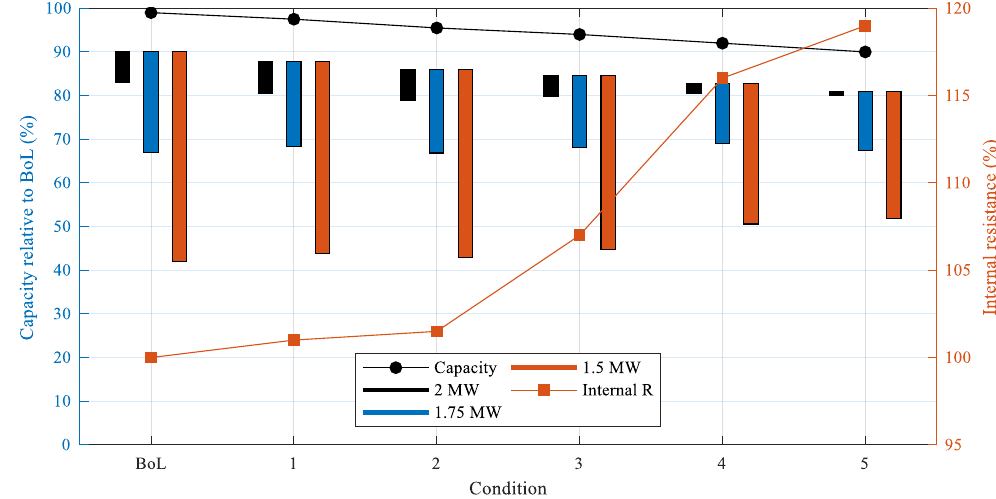
Figure 11. Battery system operating envelope with degradation condition and LDEW power to meet LDEW operational requirement of four minutes. The 2 MW, 1.75 MW and 1.5 MW results pertain to the capacity on the left-y axis.